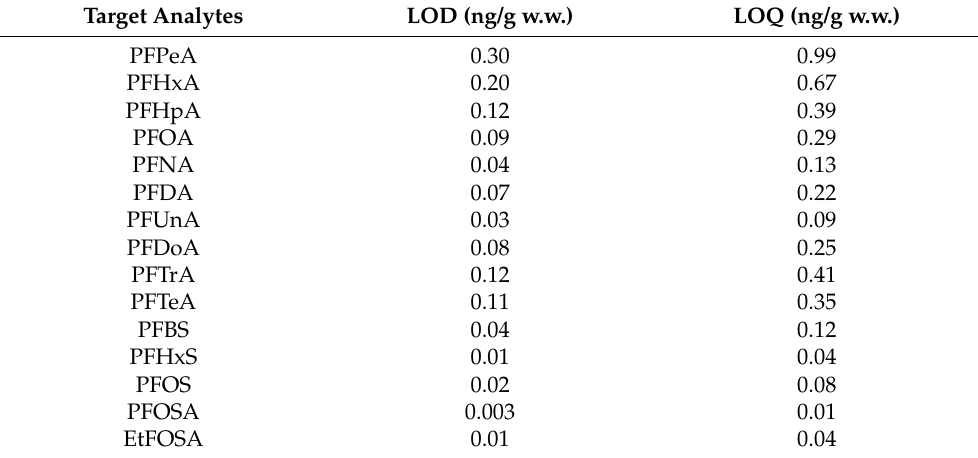
Table 1. Limits of detection and quantification for the target